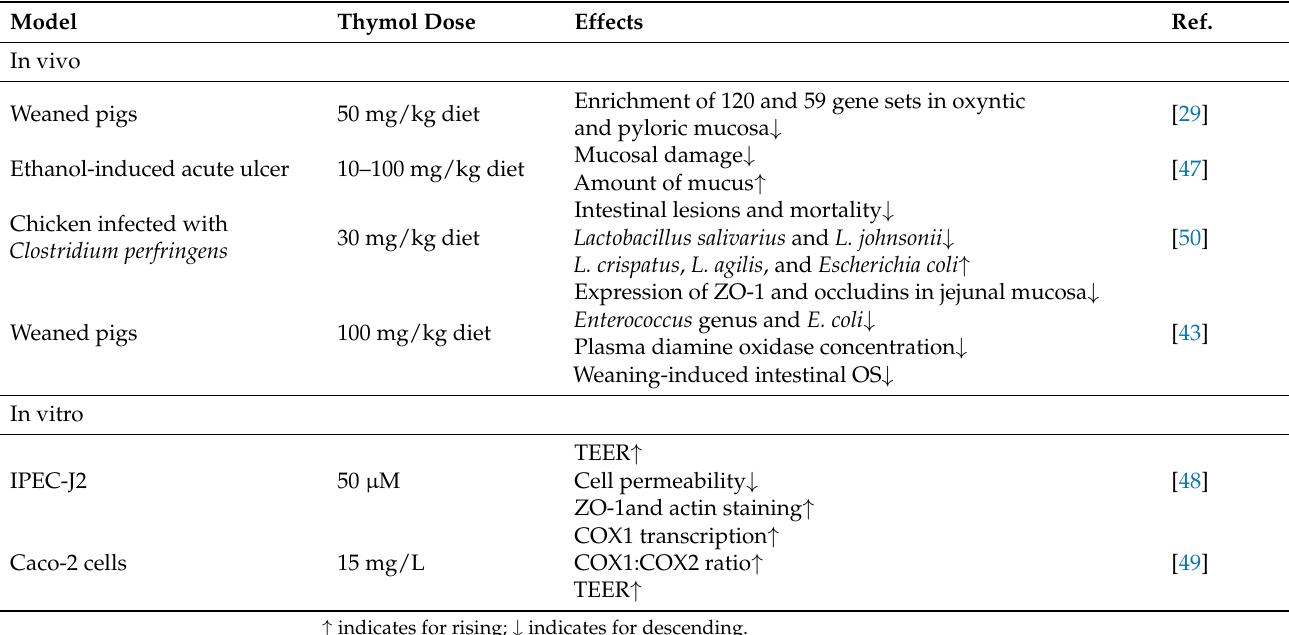
Table 1. Protective function of thymol on the intestinal barrier.